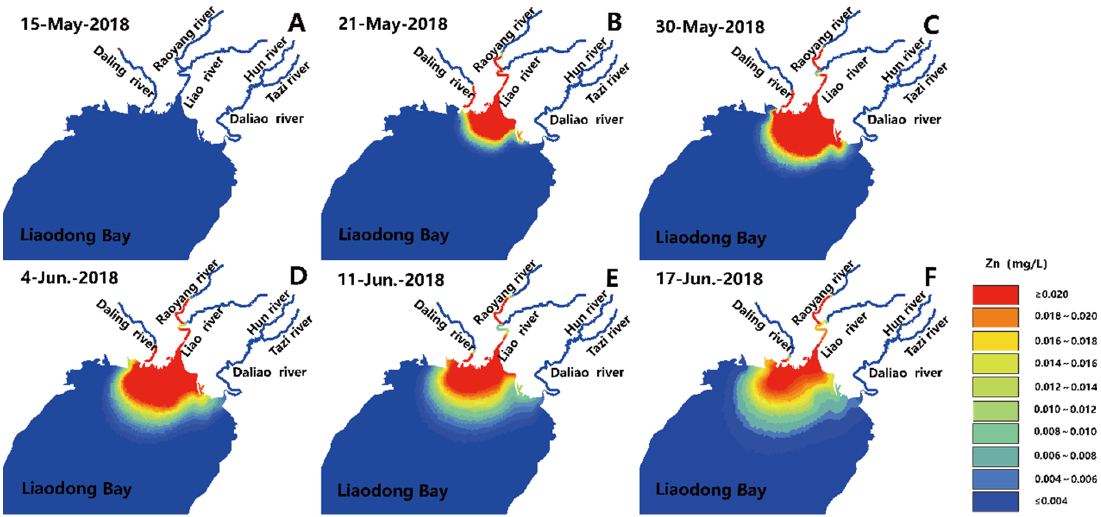
Figure 8. Daling River outbreak water pollution accident pollutant transport spread.